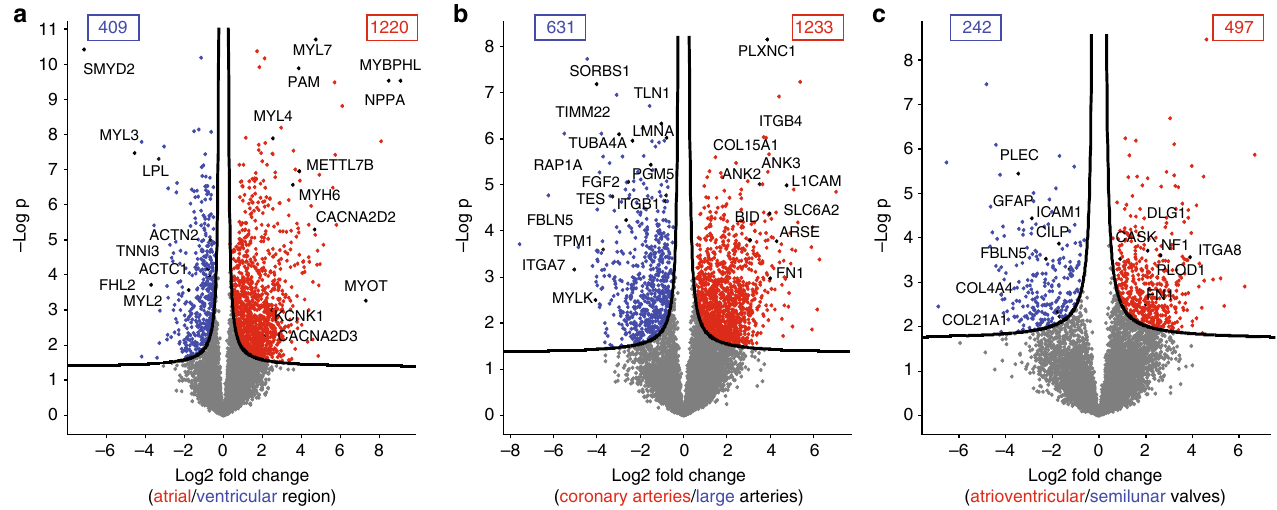
Fig. 4 Proteins differentially expressed in human heart regions. Volcano plots of the p values vs. the log2 protein abundance differences between regions, with proteins outside the signi fi cance lines colored in red or blue (FDR < 0.05). p values are calculated from the data of three healthy hearts. a Ventricular (LV, RV, and SepV) compared to the atrial (LA, RA, and SepA) regions, b coronary arteries (LCA, RCA) compared to arteries (Ao, PA), and c semilunar (AV, PV) compared to atrioventricular (TV, MV)